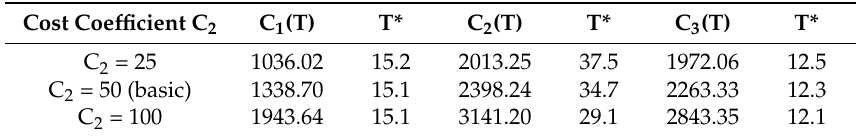
Figure 14. Expected total cost subject to the warranty period for the 3 rd condition. Table 9. Optimal release time T* according to cost coefficient C 2.